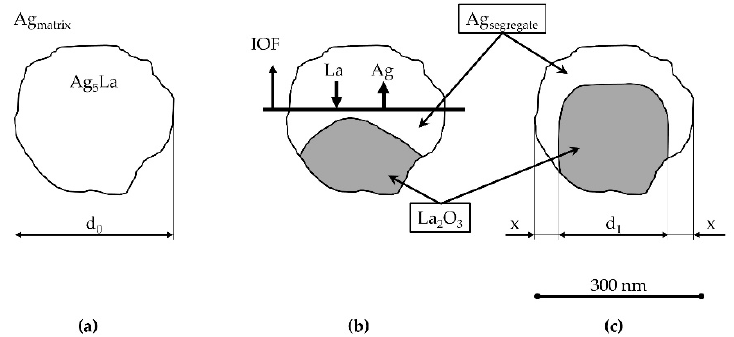
Figure 16. The oxidation model of “Small Ag 5 La Particles” in the hypoeutectic microstructure with an upward moving internal oxidation front: ( a ) submicron intermetallic particle before oxidation; ( b ) re-arrangement of atoms during oxidation; ( c ) separated area with oxide and segregated Ag.